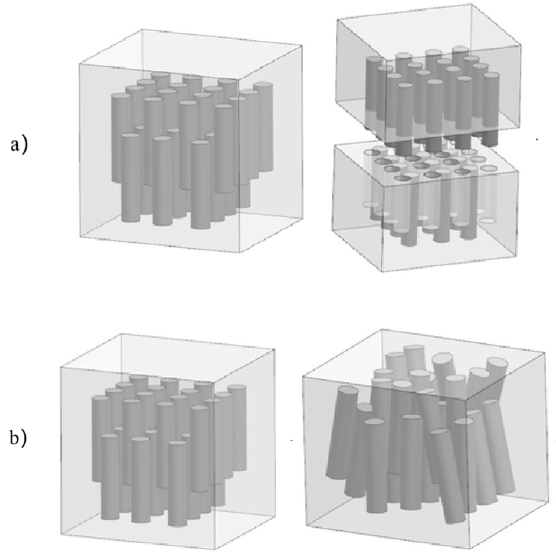
Figure 14. The change of the aspect ratio after extrusion: ( a ) The original squeeze casting, ( b ) The extrusion.